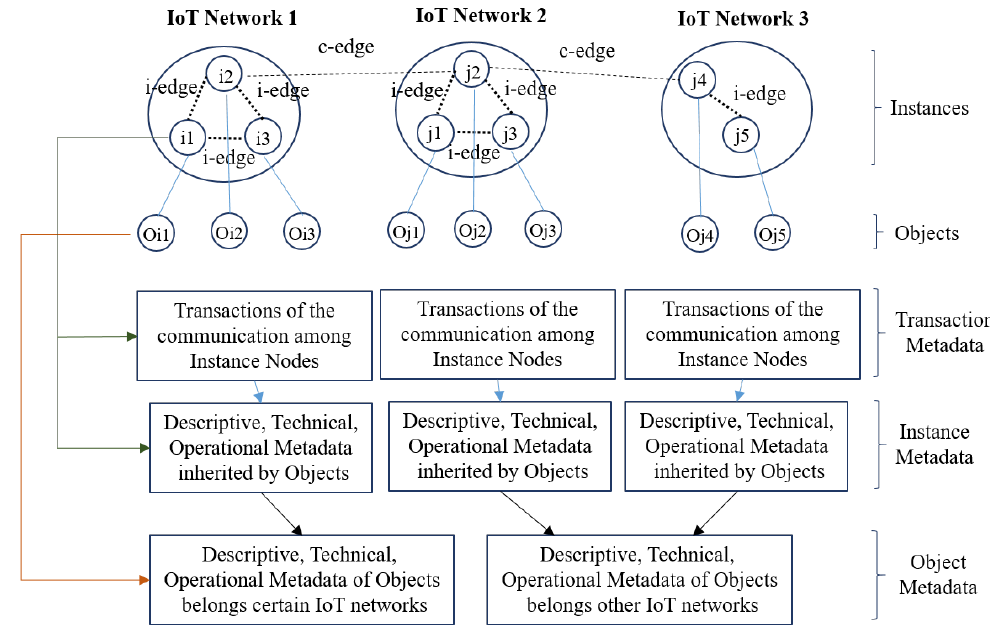
Figure 11. Multi-IoT Architecture.